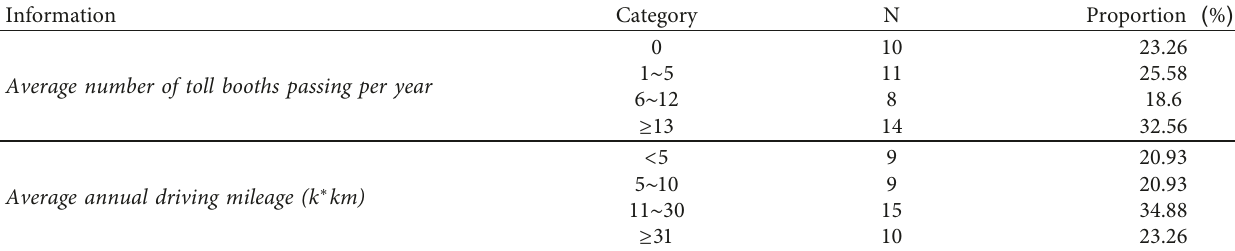
Table 1: Other information of the